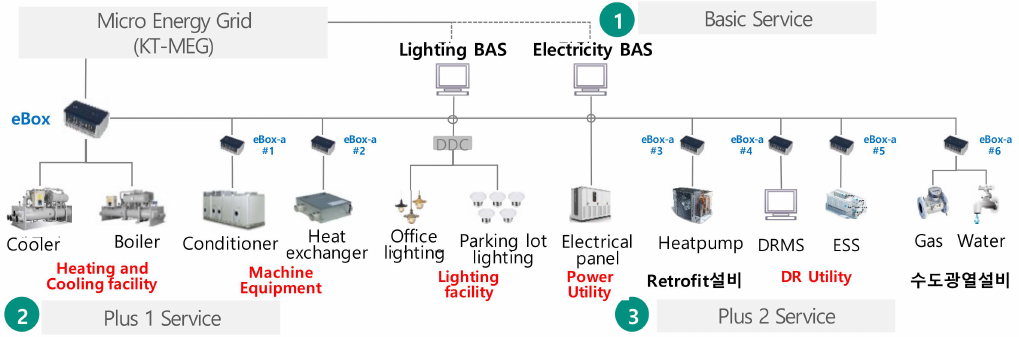
Figure 9. Architecture and business model of energy management operation